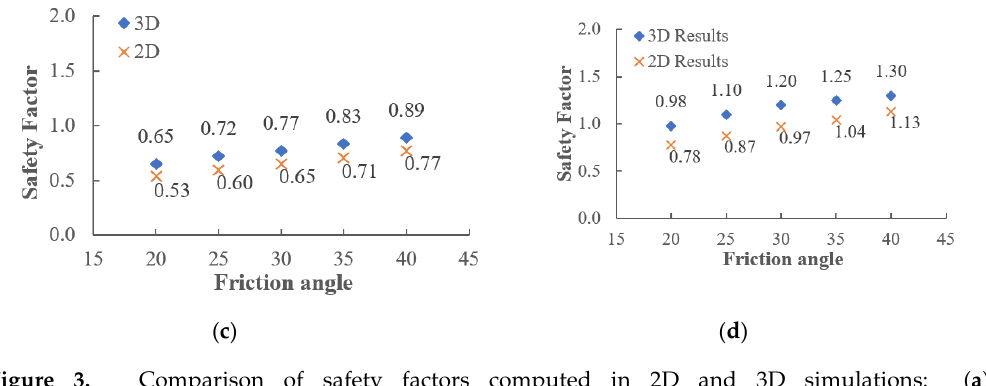
Figure 3. Comparison of safety factors computed in 2D and 3D simulations: ( a ) C = 15 m, D = 10 m, c = 5 kPa; ( b ) C = 15 m, D = 10 m, c = 10 kPa; ( c ) C = 20 m, D = 5 m, c = 5 kPa; ( d ) C = 20 m, D = 5 m, c = 10 kPa.